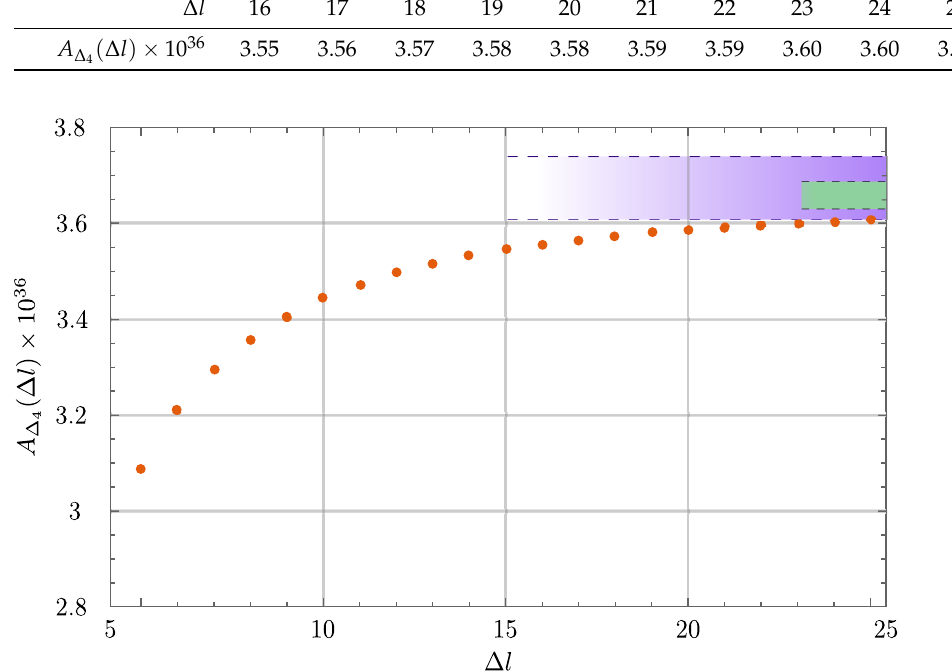
( ∆ l ) in function of the cut-off with the band (32) highlighted in purple and Figure 5. Amplitude A ∆ 4 the band (33) highlighted in green.